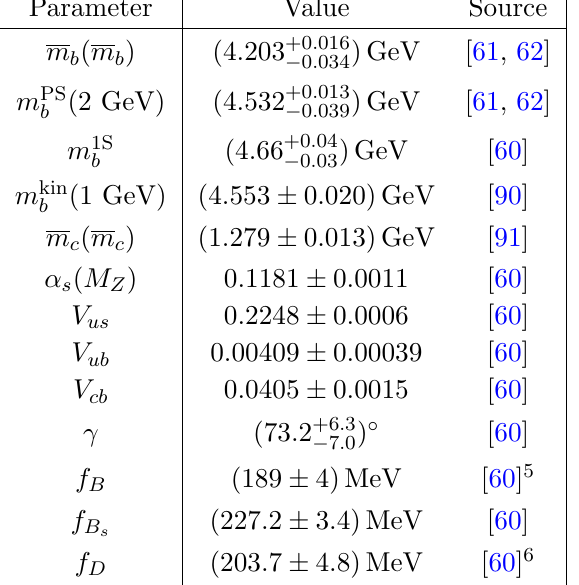
Table 1 . Input values for parameters.